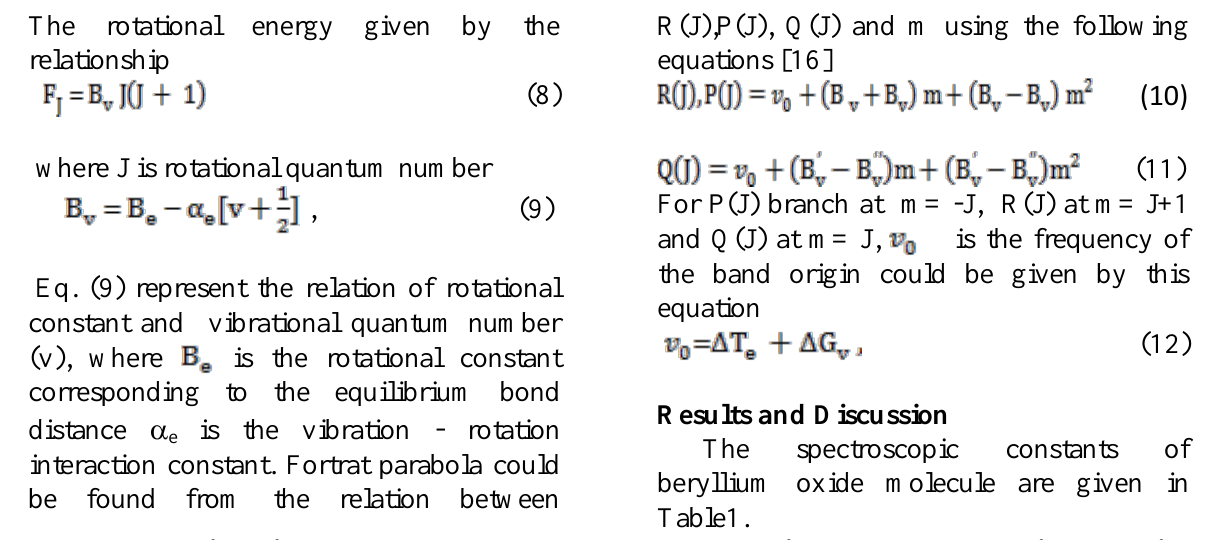
Table. 1: The diatomic constants for the ground states and the excited state of BeO used in calculation. State